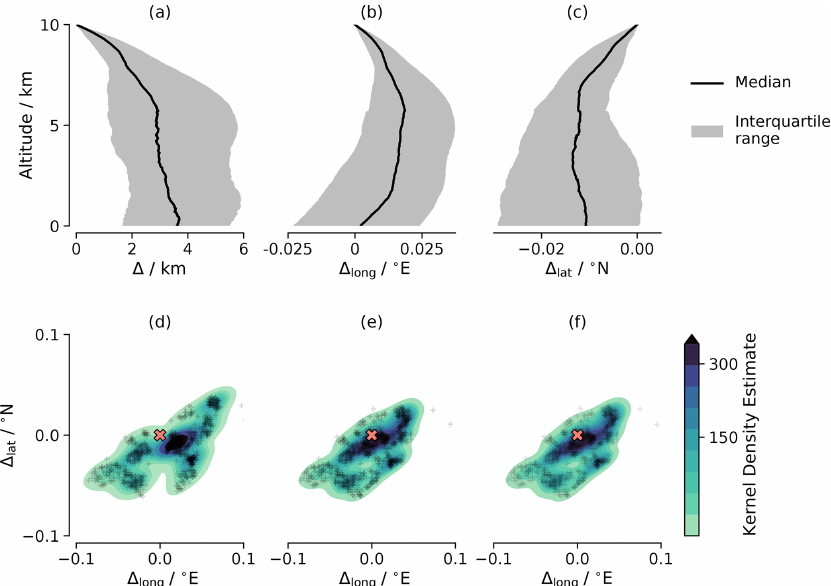
Figure 2. An overview of the drift in HALO sondes. (cid:49) indicates horizontal displacement in sondes from launch location. Panels (a) – (c) show the median drift from launch and the corresponding interquartile range for (a) horizontal displacement, (b) longitude and (c) latitude. Panels (d) – (f) show as colors the kernel density estimates (KDEs) of drift from launch location (red cross) at (d) median altitude of maximum drift in the profile, ˜ z = 3140m, (e) at sub-cloud layer mean (0–500m) and (f) at an altitude of 2km, where the cloud-top layer is usually present.